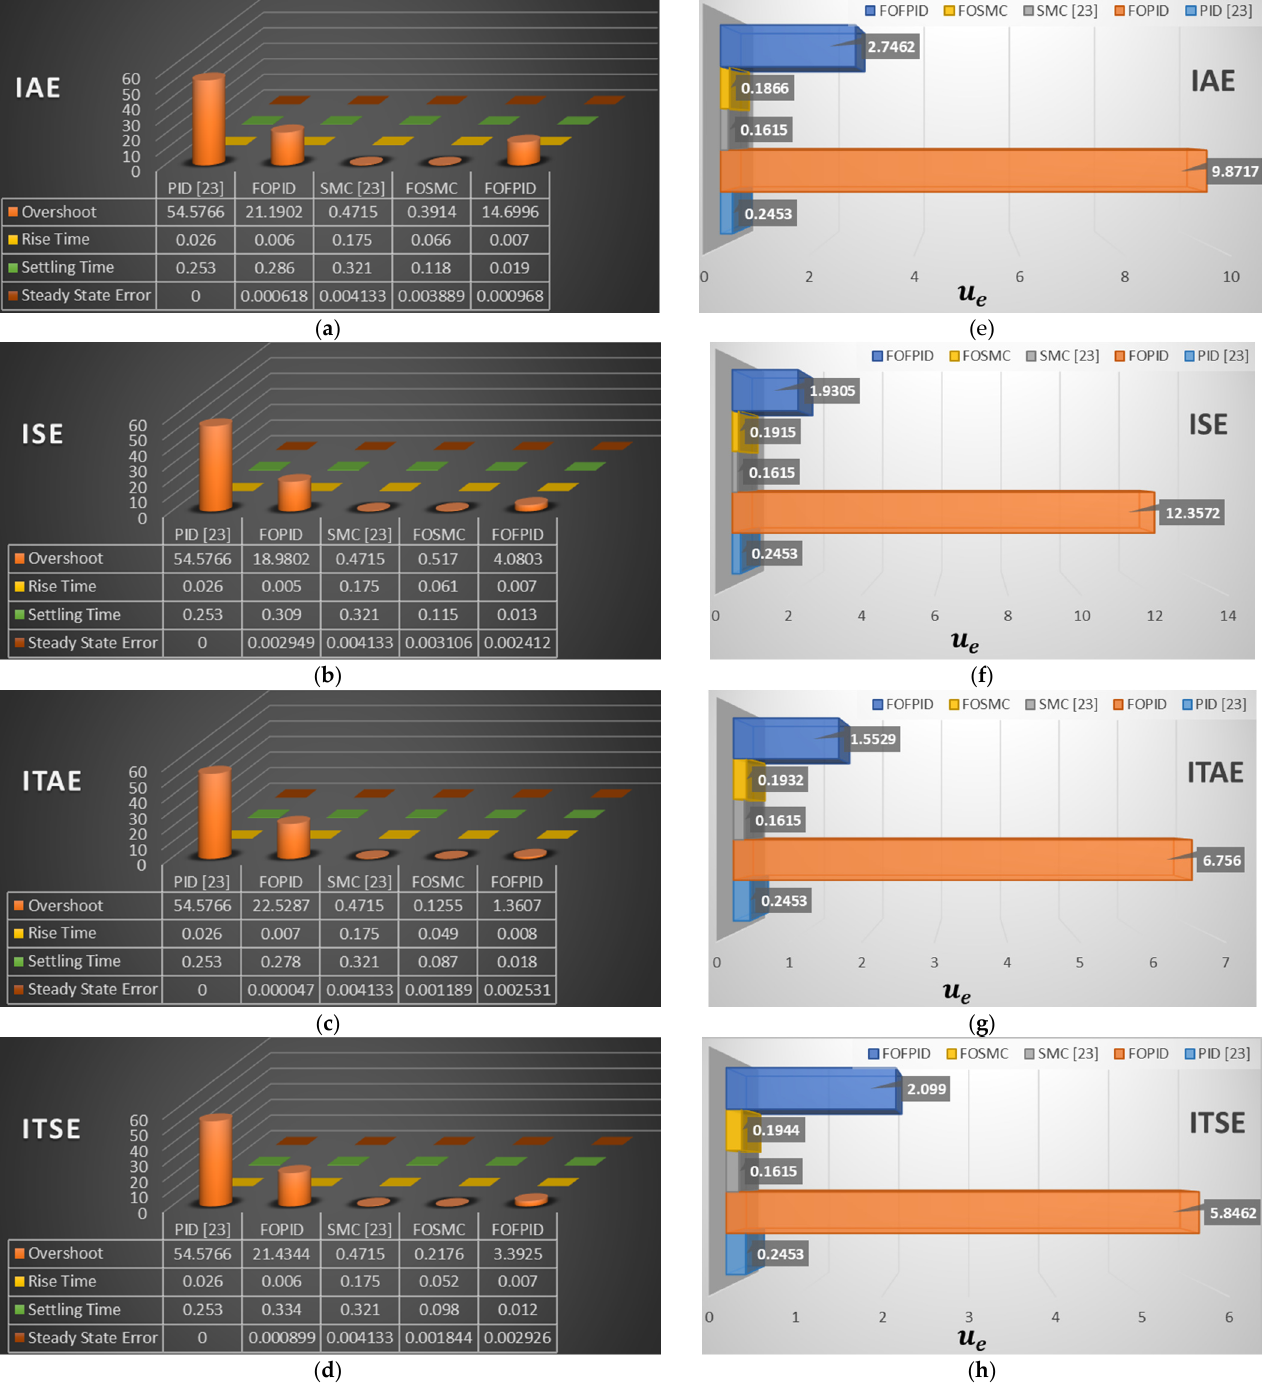
Figure 11. Dynamic response parameters ( a – d ) and control energy values ( e – h ) for the Maglev system with different controllers under parametric variation with − 10%.